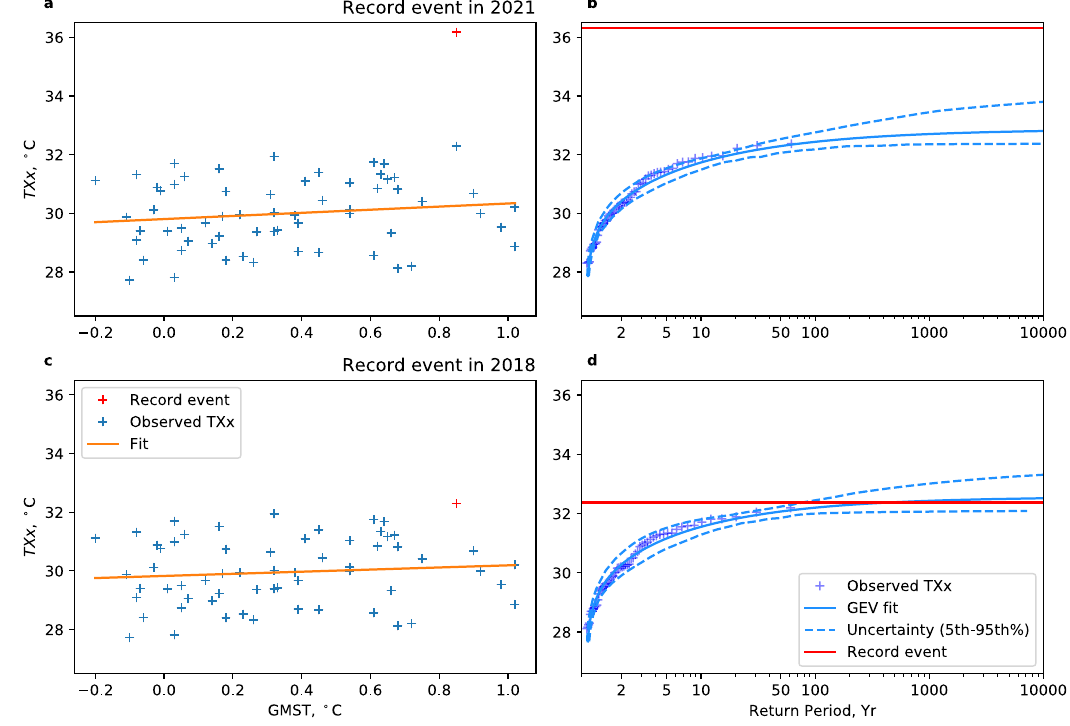
Fig.1 |GeneralisedExtremeValue(GEV) fi tofanannualmaximumofobserved daily maximum temperature ( TXx ) for Alberta, Canada. Data from ERA5 10 , 1959 – 2021. a The observed TXx plotted against global mean surface temperature (GMST). The record event of 2021, shown in red, is not included in the fi t line. b ReturnperiodplotsadjustedtothecurrentclimatebasedonGMST=1,calculated excludingthe2021event,thesolidbluelineistheGEV fi t,anddashedlinesindicate